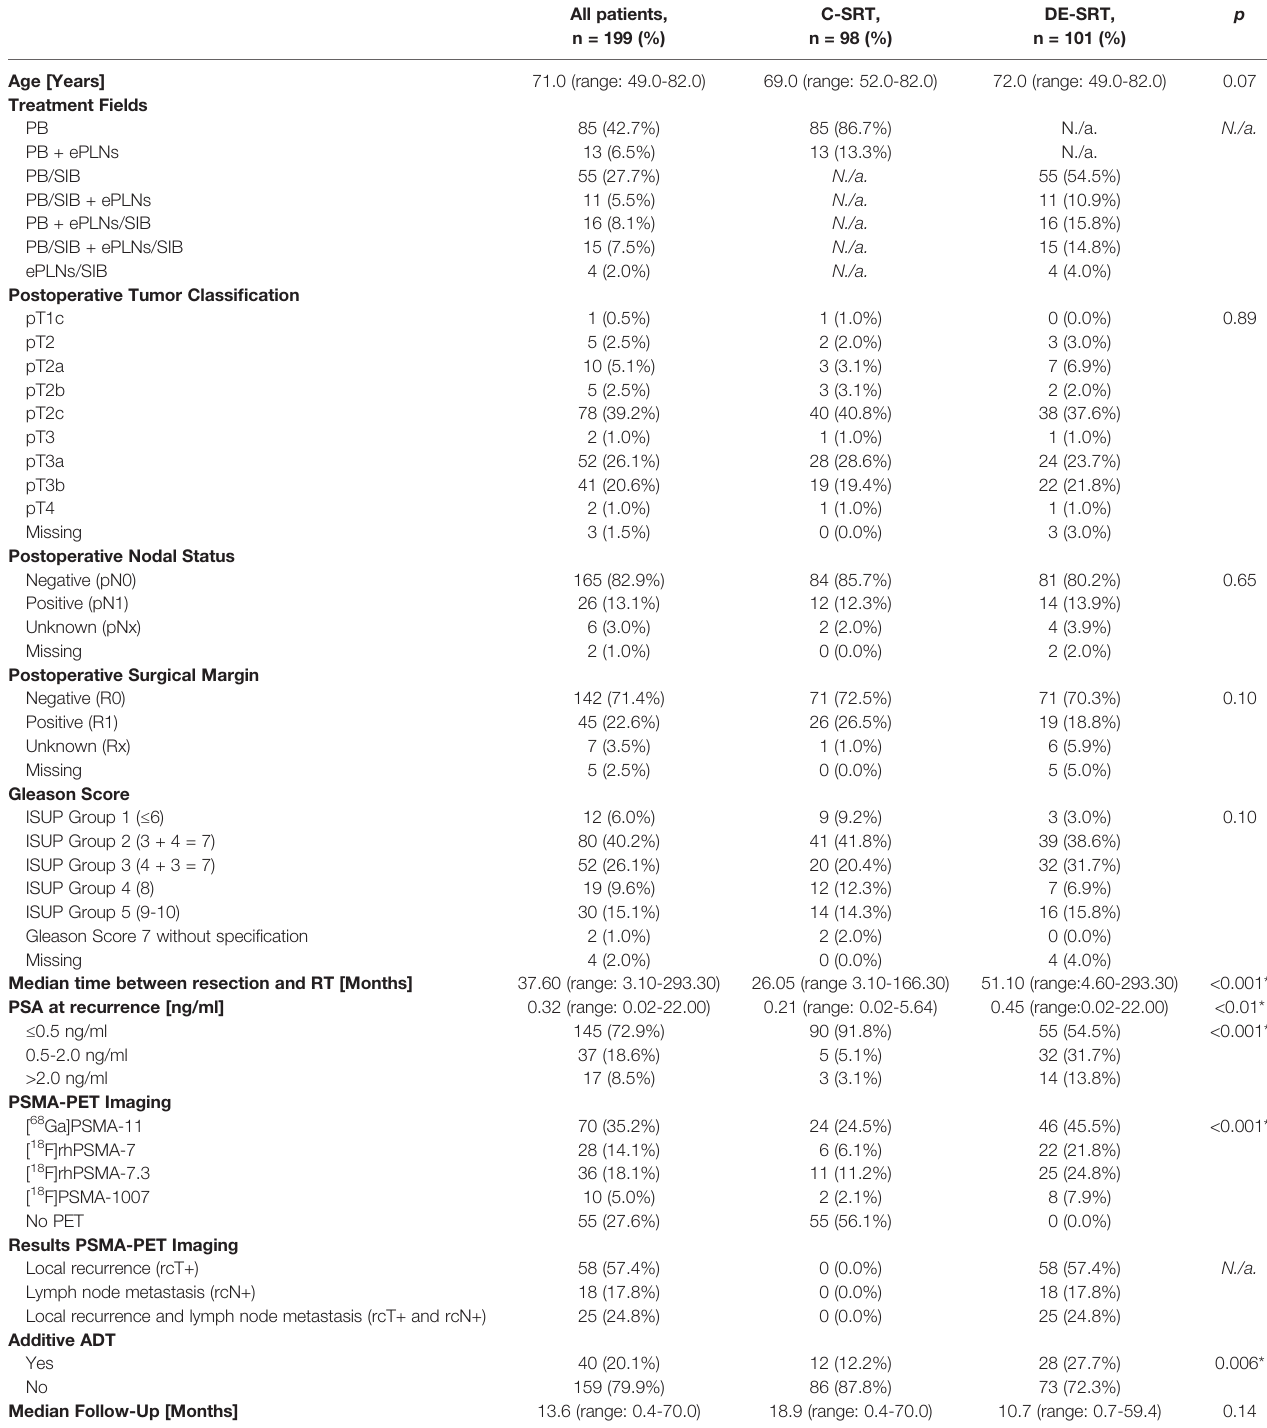
TABLE 1 | Patient